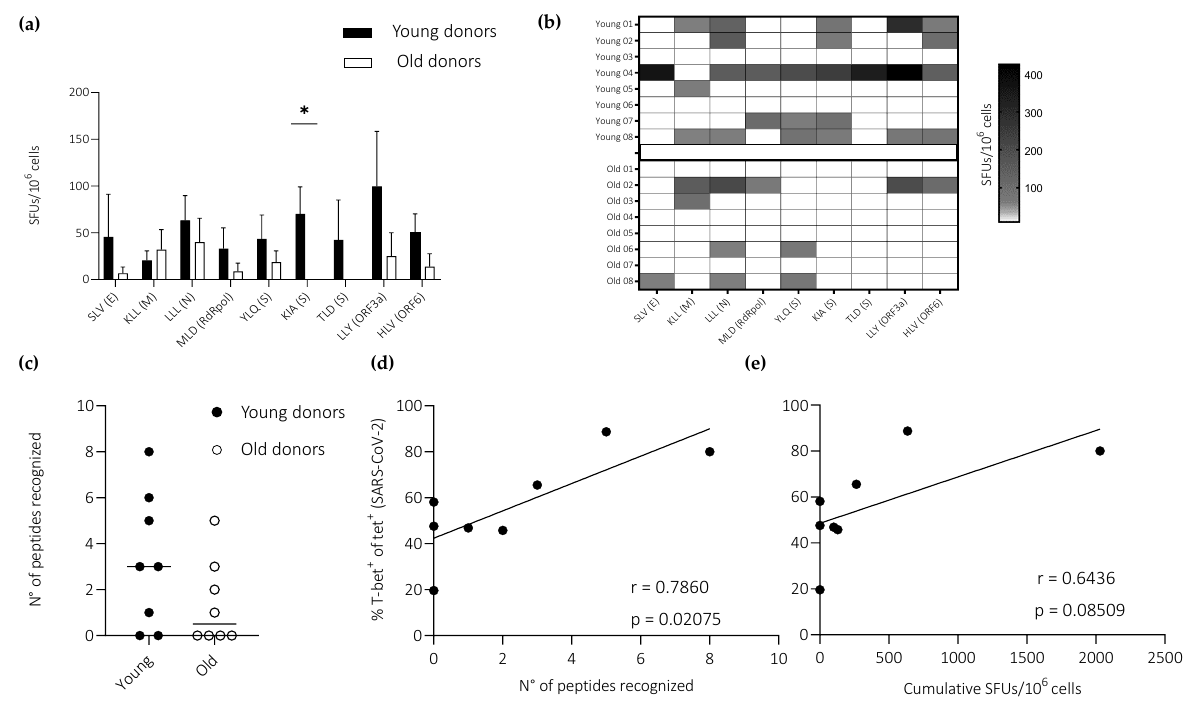
Figure 4. IFN- γ expression among primed CD8 + T cells specific for SARS-CoV-2. ( a ) Epitope- specific response frequencies quantified using ELISpot assays to capture IFN- γ after stimulation with peptides derived from SARS-CoV-2. Responses above 50 SFUs per 10 6 cells were considered positive. Data are shown as median + SEM. ( b ) Data from ( a ) shown as a heatmap. ( c ) The total number of peptides recognized by each donor. Horizontal lines represent median values. ( d , e ) Pearson correlations showing T-bet expression frequencies among SARS-CoV-2-specific CD8 + T cells versus epitope recognition frequencies, measured as a binary outcome for each peptide ( d ), and overall response frequencies, measured as cumulative SFUs ( e ). Dots correspond with the data shown in Figure 3d (young, n = 4; old, n = 4). ( a ) * p < 0.05 (Mann–Whitney U